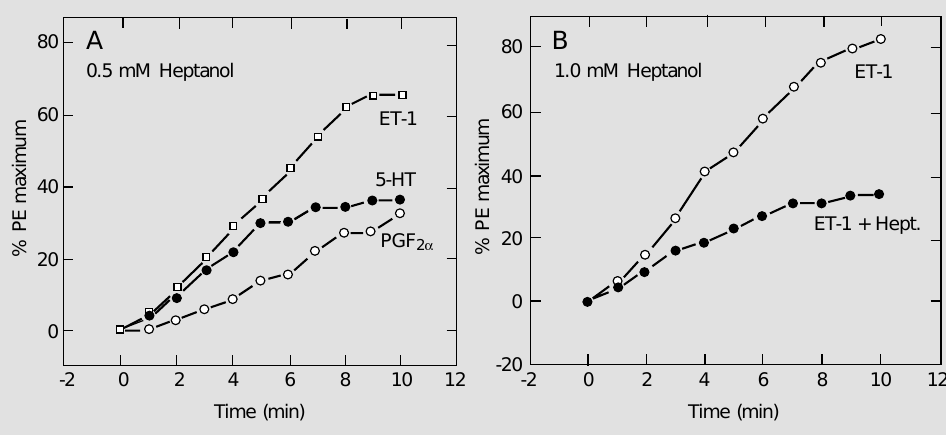
Figure 1 - Time course of re- sponse generation for endothe- lin-1 (ET-1)-, prostaglandin F 2 a (PGF 2 a )- and 5-hydroxytrypta- mine (5-HT)-induced contrac- tions in the presence of 0.5 mM heptanol (Hept.) (panel A). Panel B depicts the effects of higher heptanol concentrations on ET- 1-induced contractions. Each tracing illustrates representative contractile responses measured at 1-min intervals in a single (dis- tinct) aortic ring. PE, Phenyleph-